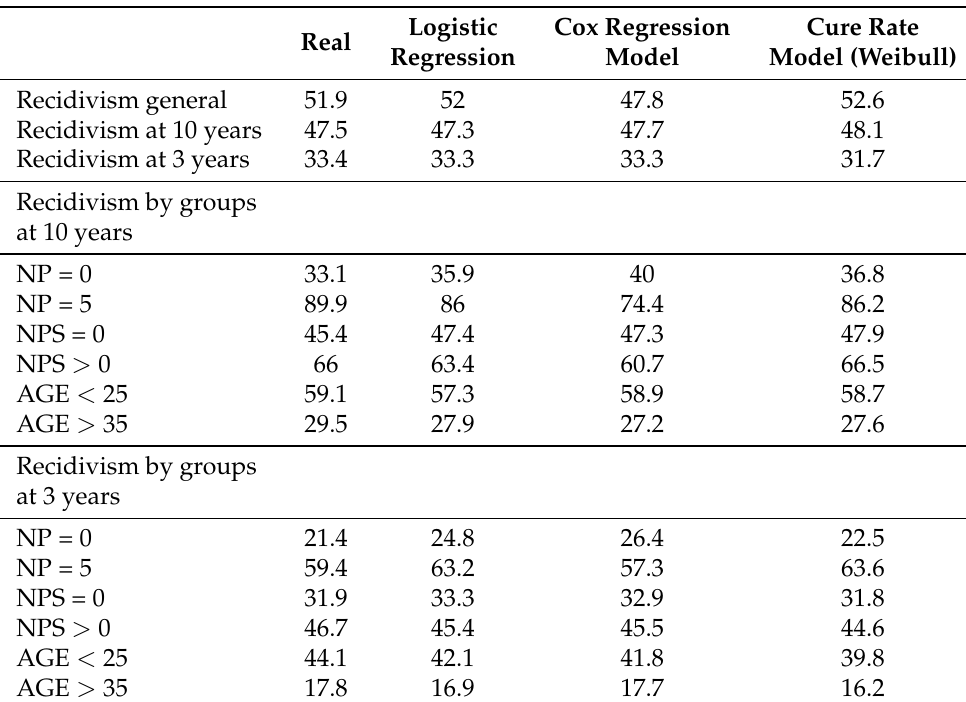
Table 2. Percentages of global and by-group recidivism for the logistic regression, Cox, and Cure rate models at 3 and 10